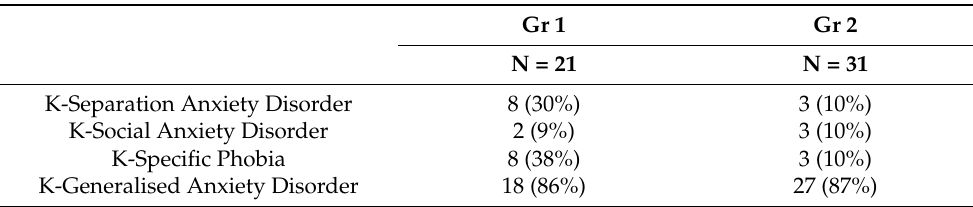
Table 2. Frequencies and percentage frequencies of anxiety disorders (K-SADS PL DSM-5) calculated separately for Group 1 (ASD + AD) and Group 2